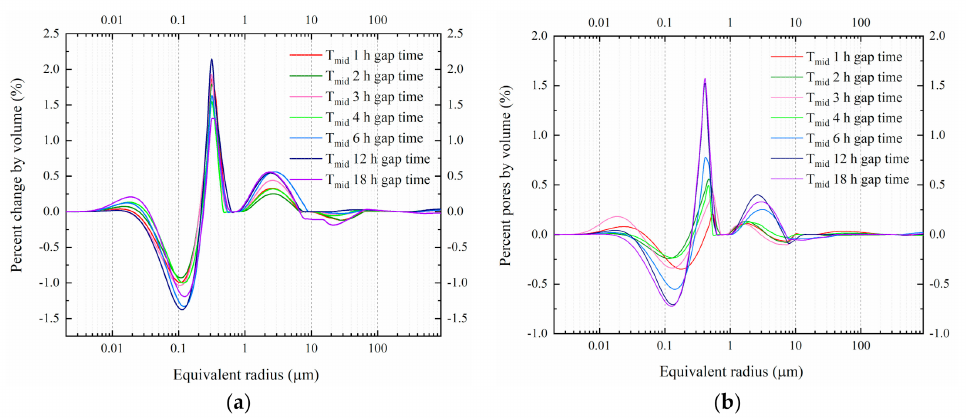
Figure 16. ( a , b ) PSD change at different freezing gap